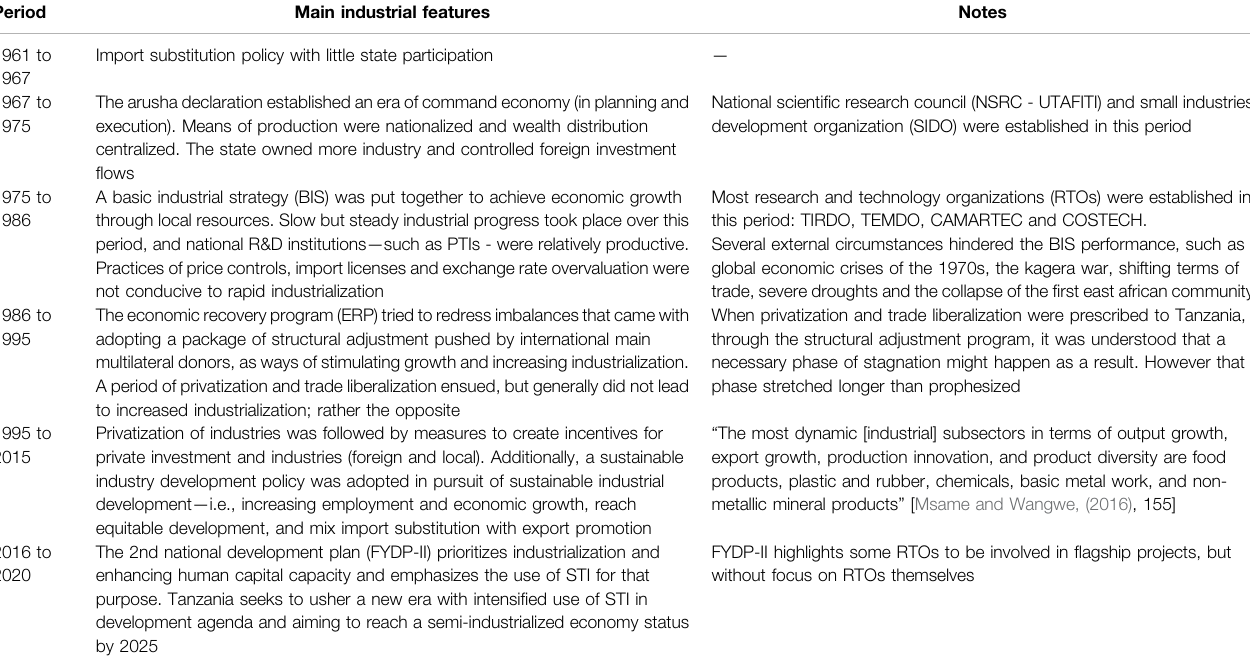
TABLE 1 | Summary of history of industrial development since independence in Tanzania a